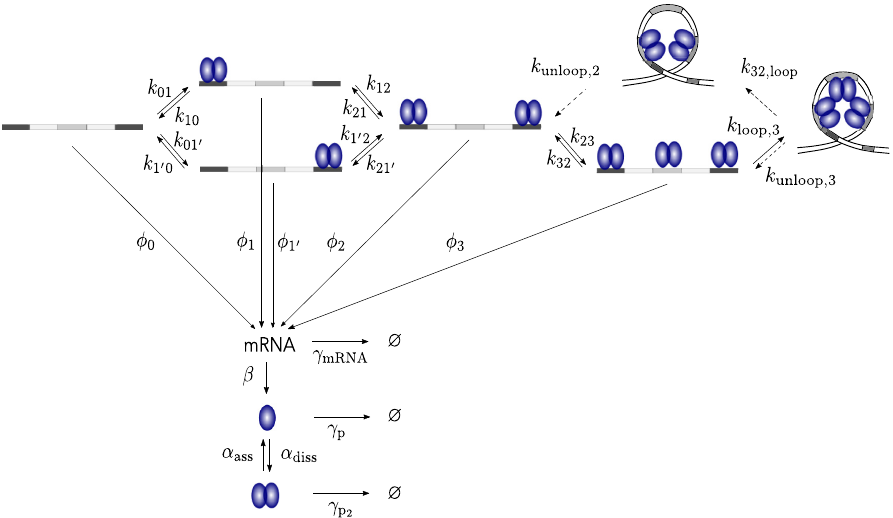
Fig 7. Schematic of the Ss-LrpB system. Ss-LrpB is a dimeric auto-regulative transcription factor. The control region of its own gene contains three binding sites of which the first and third one have a high affinity. Due to cooperativity the middle site will get bound and the DNA subsequently loops on itself. The system of unbinding is unknown and two hypotheses, either through direct unlooping or either by first unbinding the protein of the middle site, are denoted by dashed arrows. All DNA configurations have their own transcription rates, which lead to a non-monotonic response curve. mRNA will be translated to monomers which can dimerize. The model also takes into account degradation/ dilution of all proteins (mRNA, monomers and